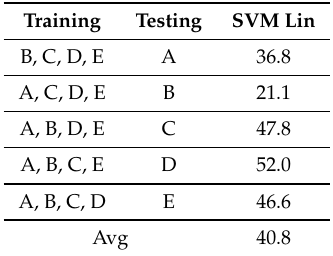
Table 9. Support Vector Machines classifier with linear kernel function performance when the multiclass method was changed from one-vs-one to one-vs-all.